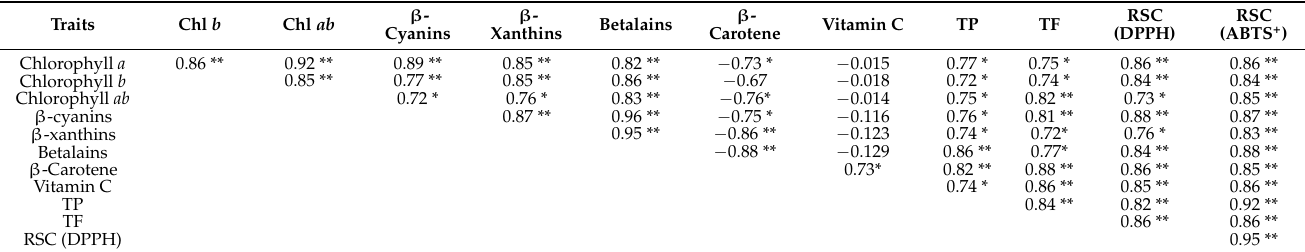
Table 5. The coefficient of correlation of antioxidant pigments, TPC ( µ g GAE g − 1 FW), β